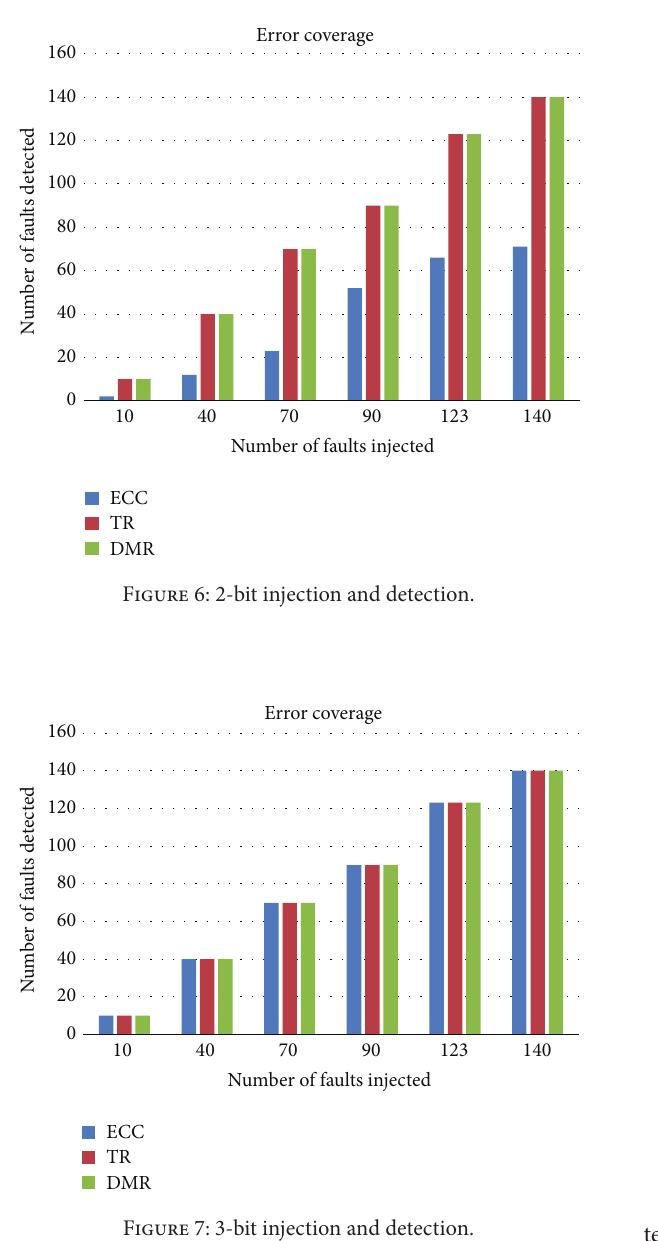
Figure 7: 3-bit injection and detection.